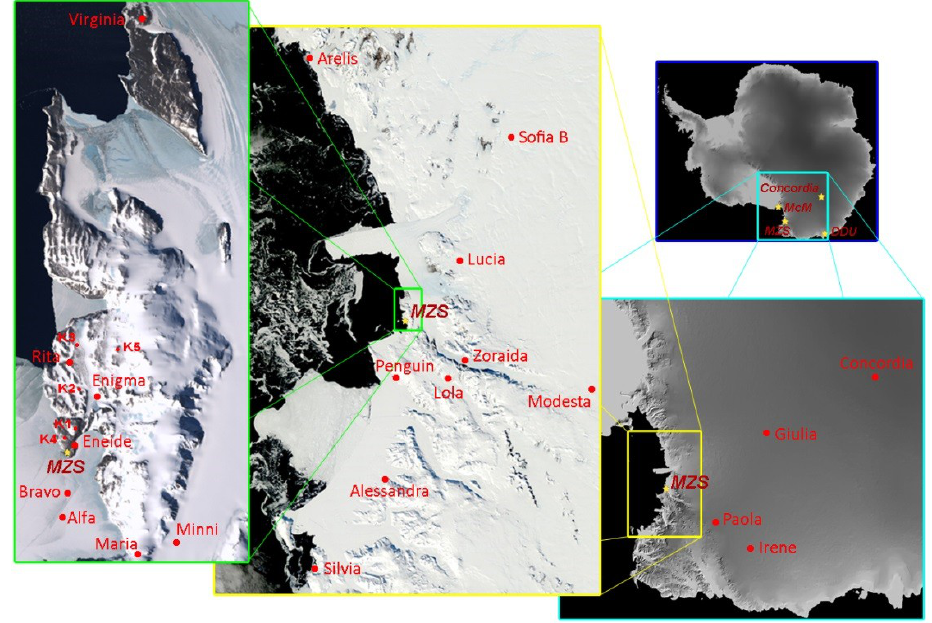
Figure 1. Map of Antarctica with the locations of the Italian Automatic Weather Stations [1].